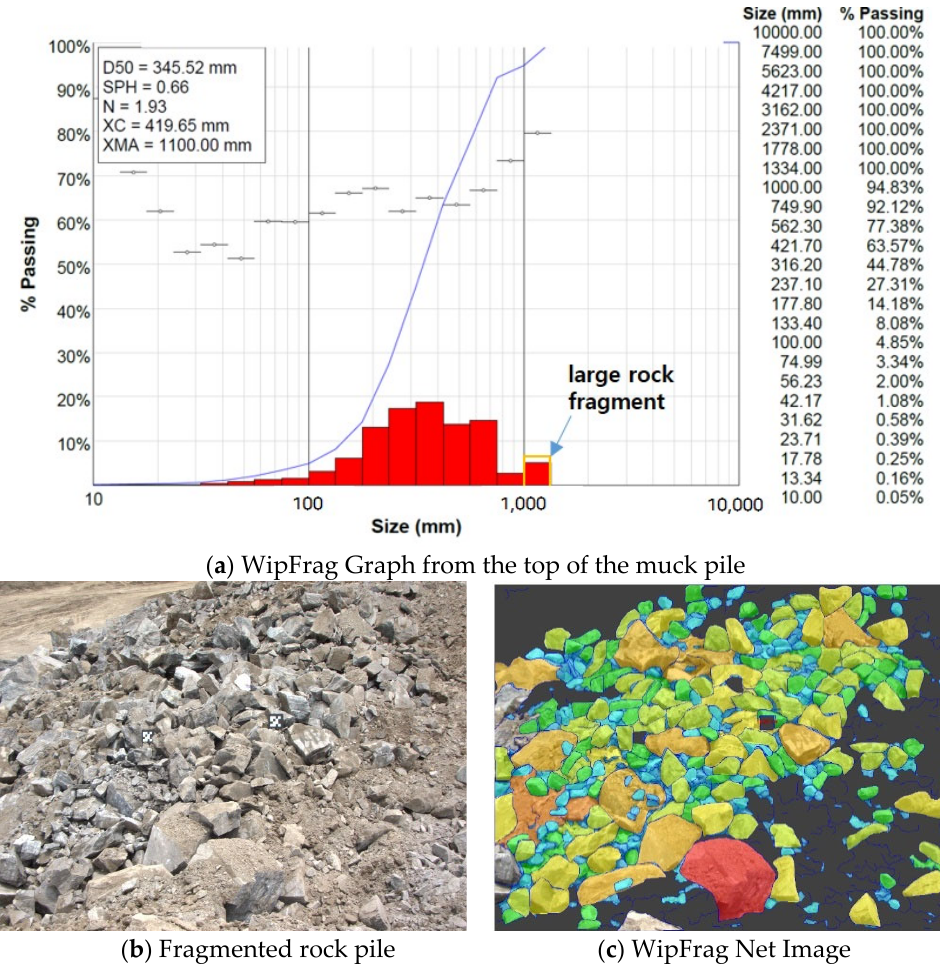
Figure 13. Rock pile image, contouring, histogram, and cumulative size curve of the fragmented block (bench top image of STF stemming case after blasting).